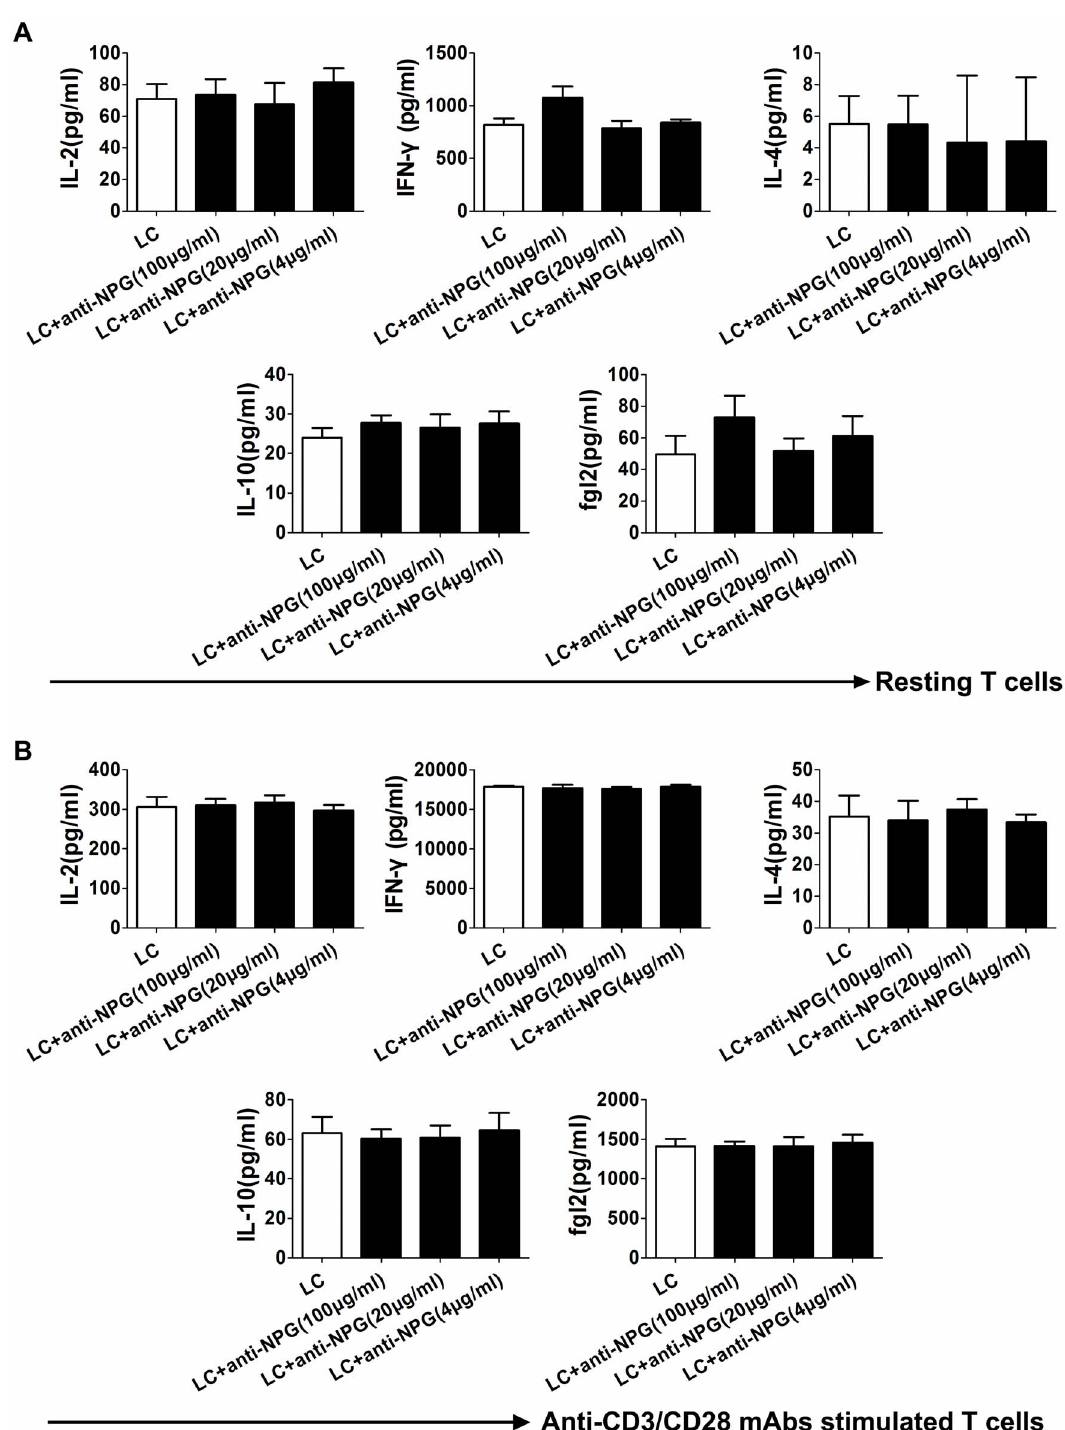
Figure 7. Anti-NPG-12 antibodies exhibited no influence on the polarization of human peripheral blood T lymphocytes. (A) No significant differences were observed in the levels of IL-2, IFN- c , IL-4, IL-10 and secreted fgl2 in the supernatants from the resting T lymphocytes, as determined by ELISA ( P . 0.05). The values are the means 6 S.E.M (n=3). (B) No significant differences were observed in the levels of IL-2, IFN- c , IL-4, IL-10 and secreted fgl2 in the supernatants from the proliferated T lymphocytes stimulated by anti-CD3/CD28 mAb, as determined by ELISA ( P . 0.05). The values are the means 6 S.E.M (n=3). LC: lymphocytes, anti-NPG: anti-NPG-12 antibodies. doi:10.1371/journal.pone.0094551.g007 which are with acceptable hydrophilic and antigenicity deter- lular domains and molecular surface of membrane-bound hfgl2, mined by HomoloGene and DNAstar (Fig. 2) [2,10,20,23]. theoretically it will be easier for antibodies to bind them through Moreover, because all these peptides are located in the extracel- direct interaction.